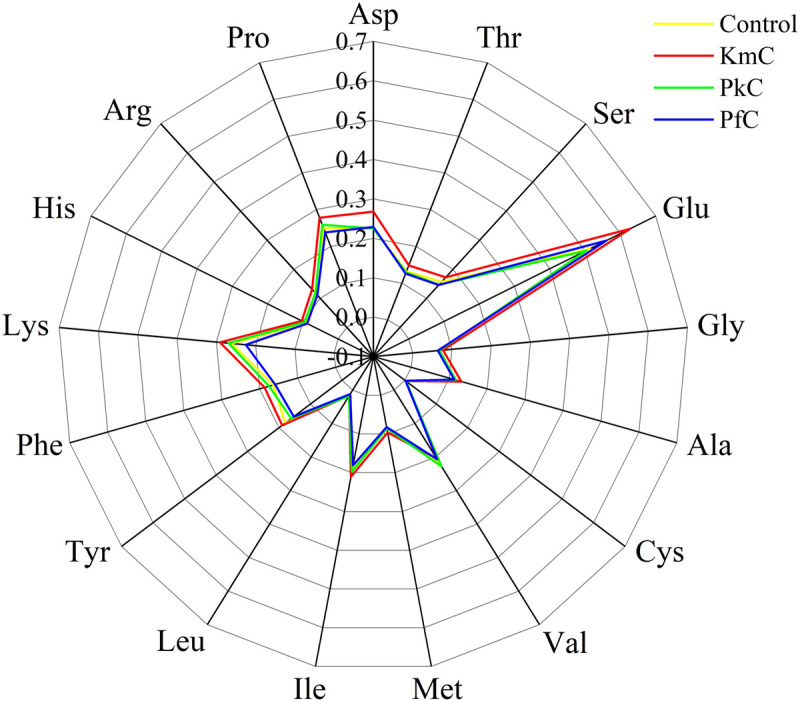
Amino acid contents in four cheeses. The letters in the rose wind direction figure indicate 17 kinds of amino acids.